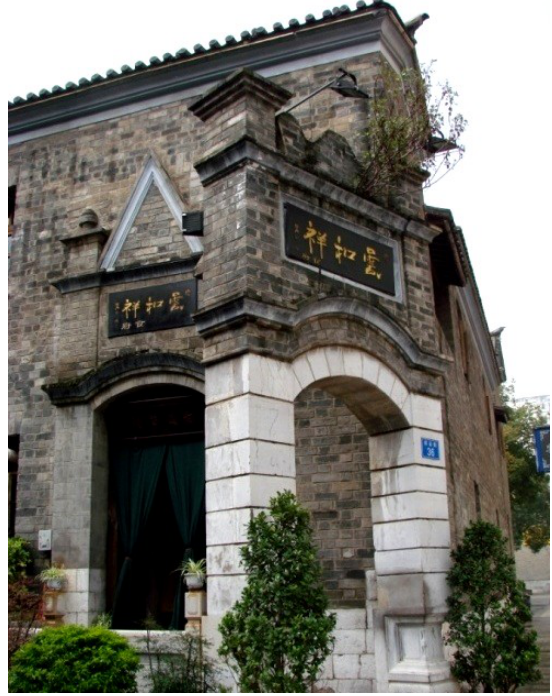
Figure 9. Historic Landmark as Cultural Destination